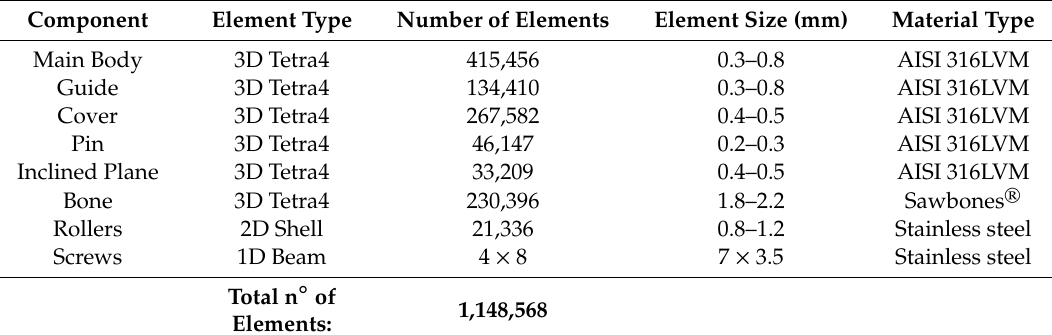
Figure 5. FE2 model with respective loads and boundary constraints; detail of one screw modelling section. Table 2. Details about finite element mesh of the whole bone-plate